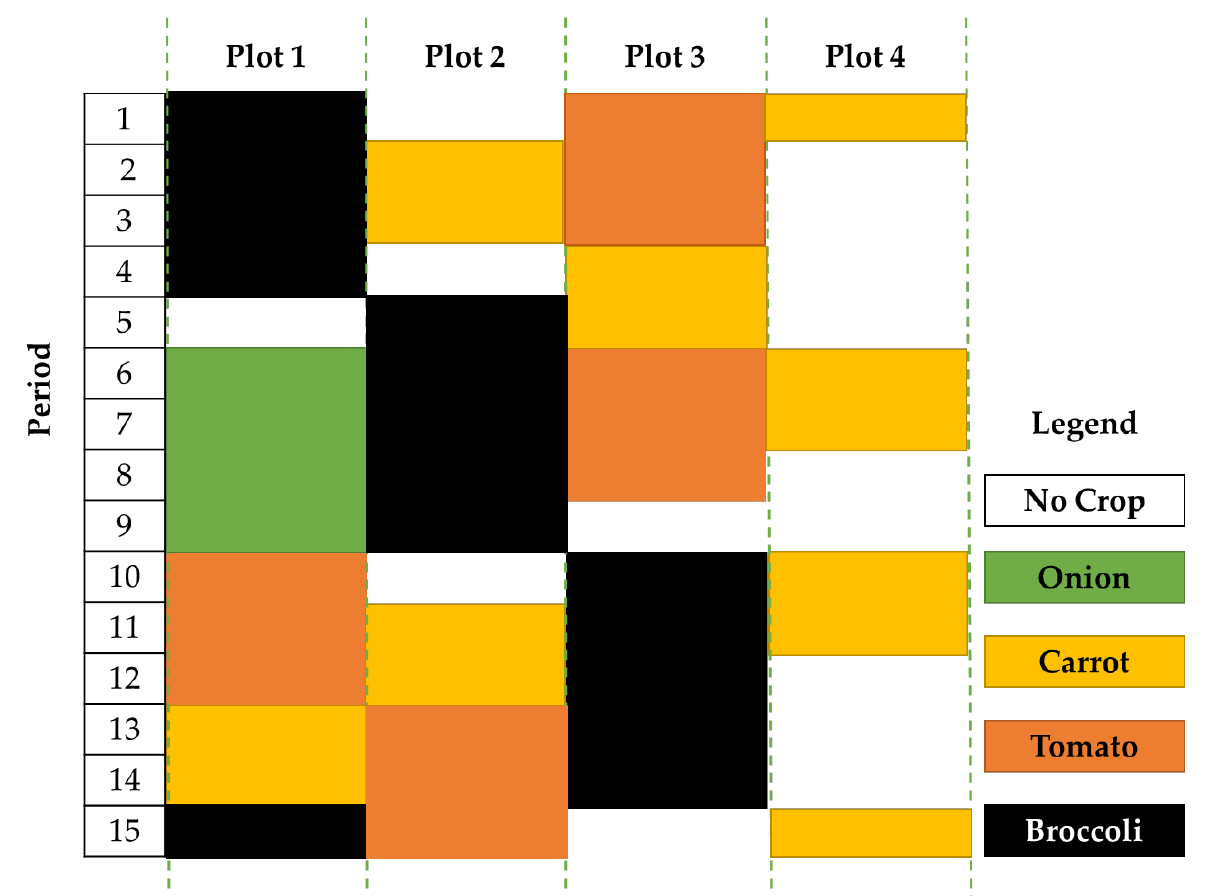
Figure 4. Representation of the solution obtained by Cbc in scenario 2. Broccoli is cultivated once on plots 1, 2, and 3. Onion is cultivated only on plot 1. Carrot is cultivated once on plots 1 and 3, twice on plot 2, and thrice on plot 4. Finally, Tomato is cultivated once on plot 1 and 2, and twice on plot 3.